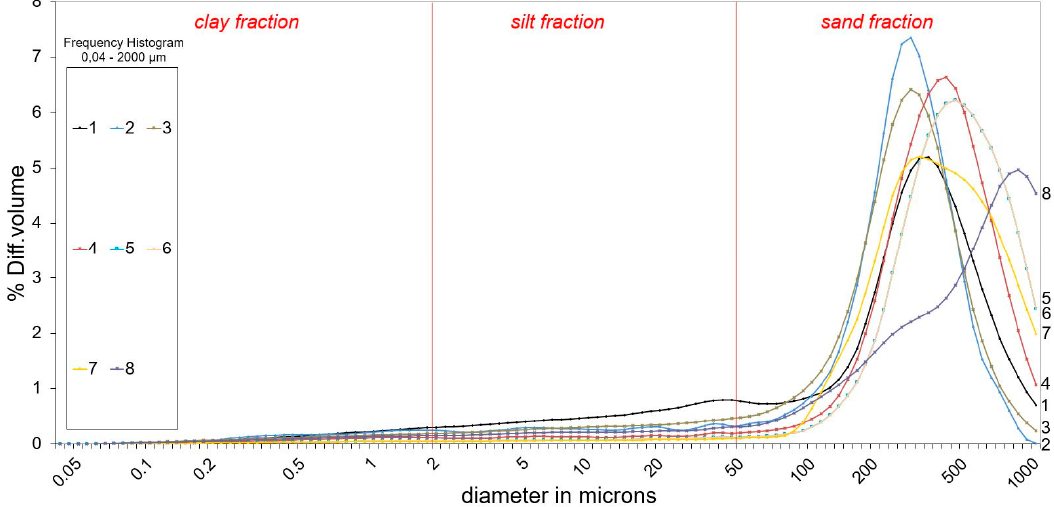
Figure 7. Textural type percentages from T4 outcrop (see Figure 6).